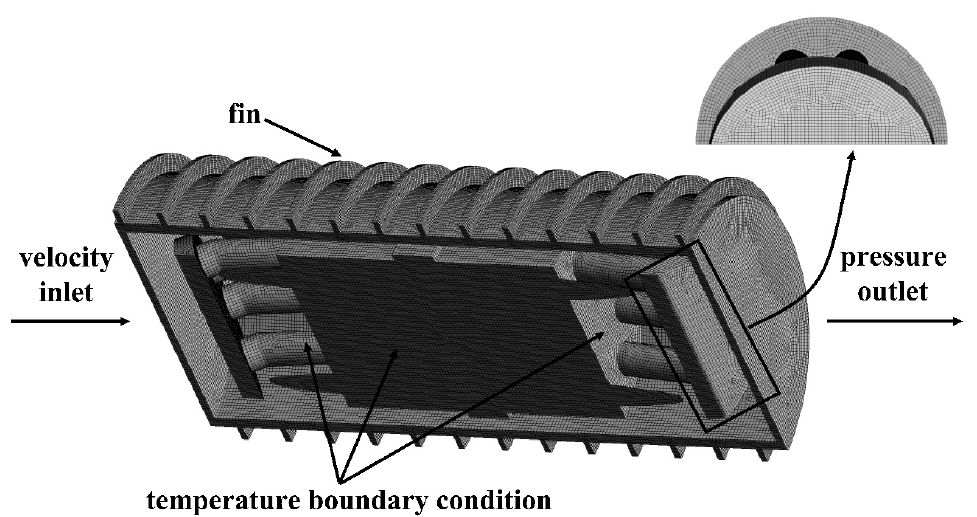
Figure 5. Simulation model and boundary conditions.